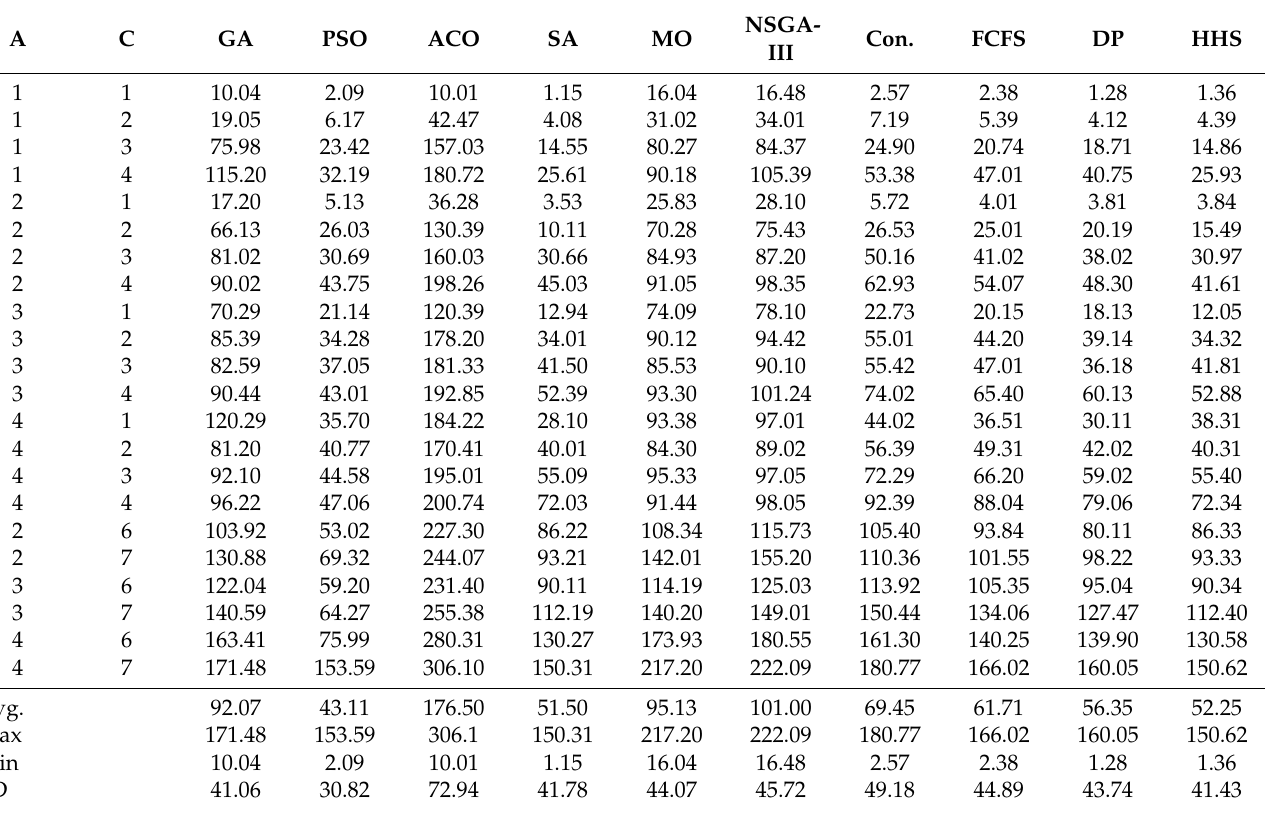
Table 7. Simulation execution times (seconds) for scheduling algorithms. (Con.: concurrent; MO: MaOPSO; Avg.: